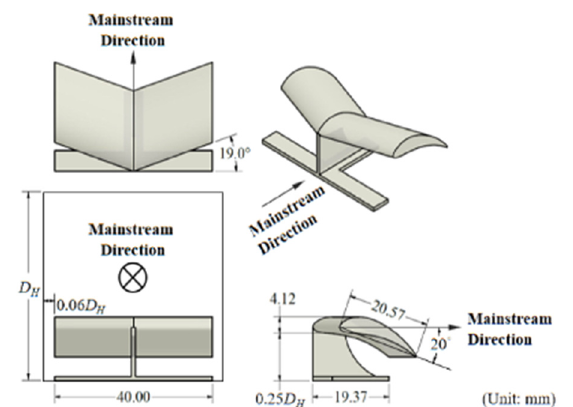
Figure 6. Wing ‐ shaped turbulators. Reprinted with permission: License number 5177110018029. Figure 6. Wing-shaped turbulators. Reprinted with permission: License number